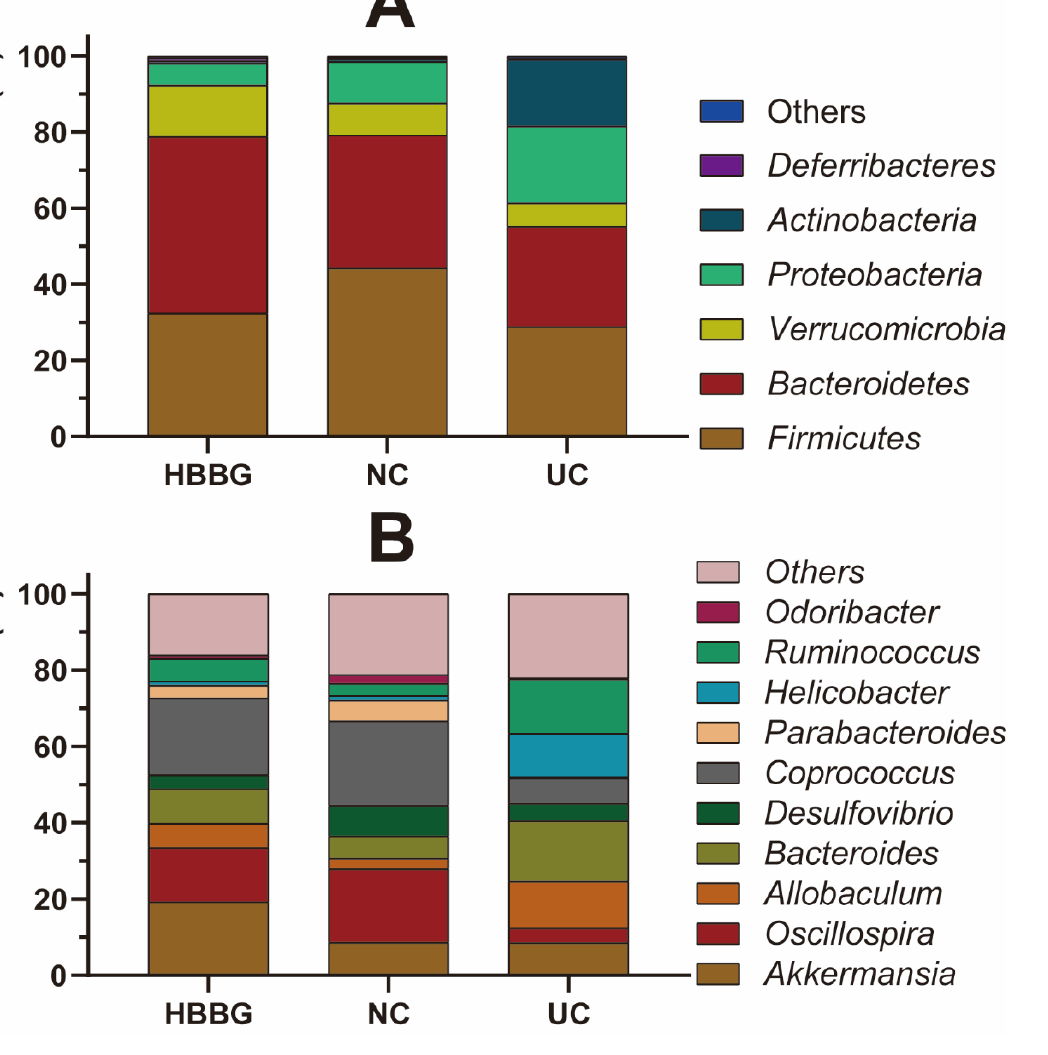
Figure 6. The effects of HBBG on intestinal flora: ( A ) phylum level; ( B ) genus level.